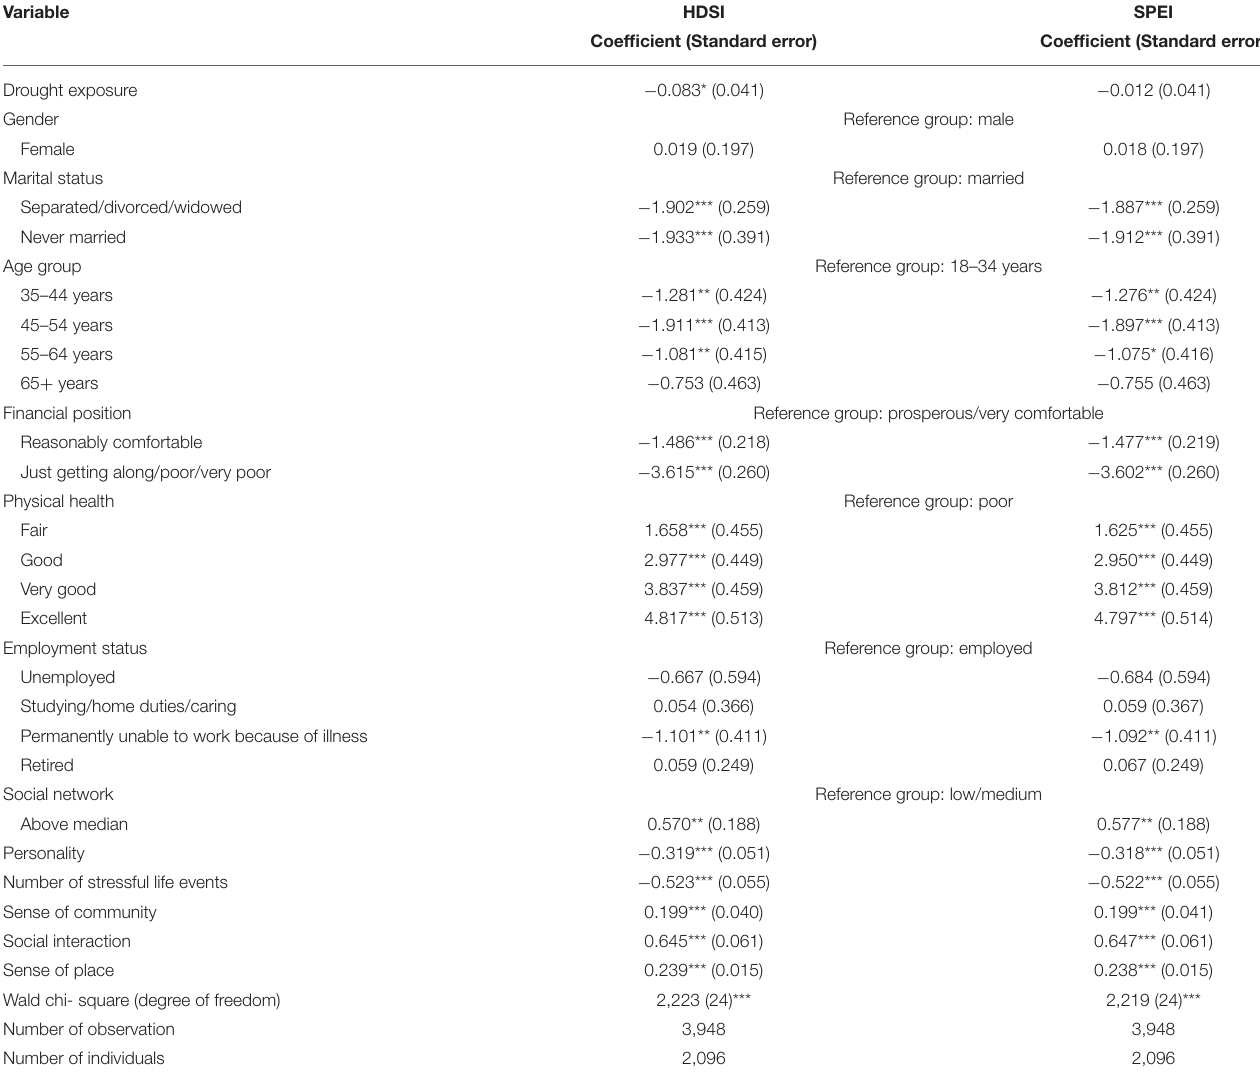
TABLE 3 | Regression results testing the linear relationship between drought and life satisfaction.